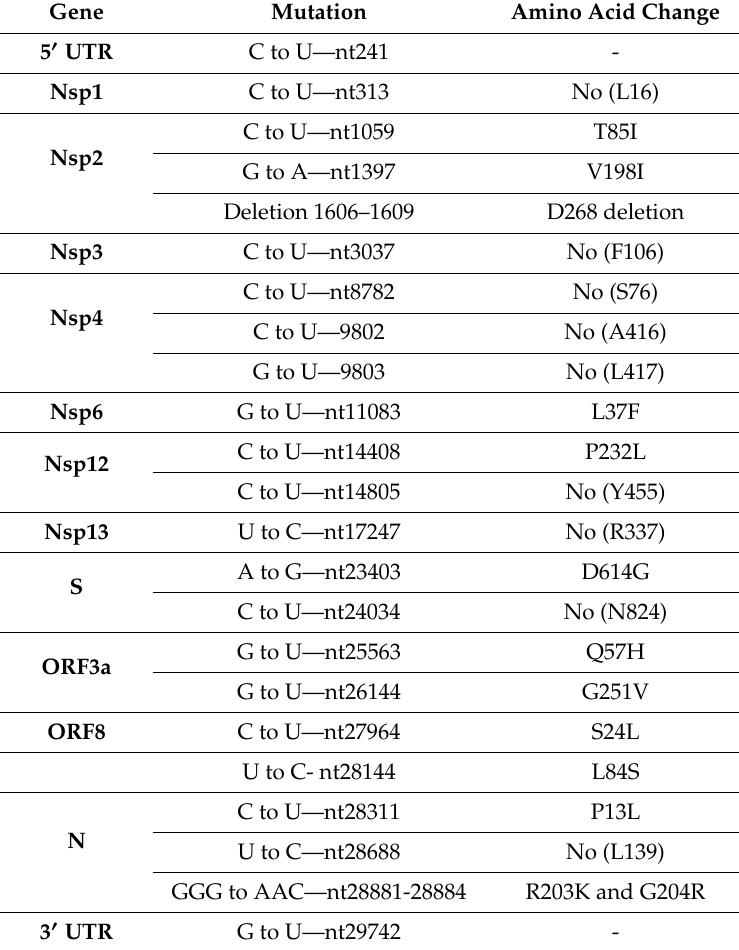
Table 1. Conserved mutations in SARS-CoV-2